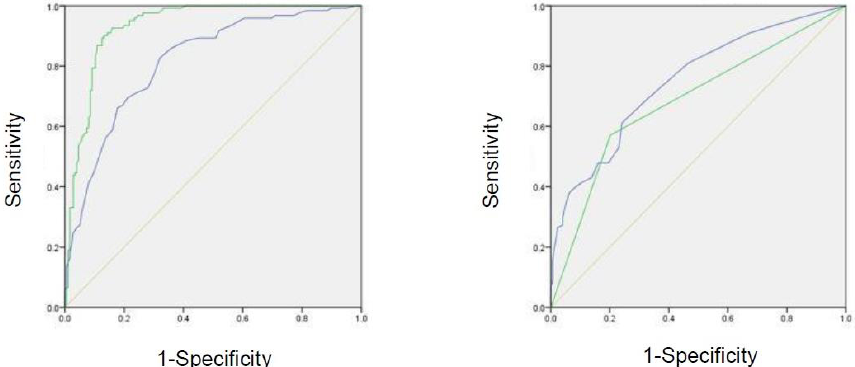
Figure 2. ROC curve of effective factors for the screening of carotid artery calcification. Green line in the left panel represents the rate of ABL. Blue line in the left panel represents the age. Green line in the right panel represents hypertension. Blue line in the right panel represents the number of present teeth.